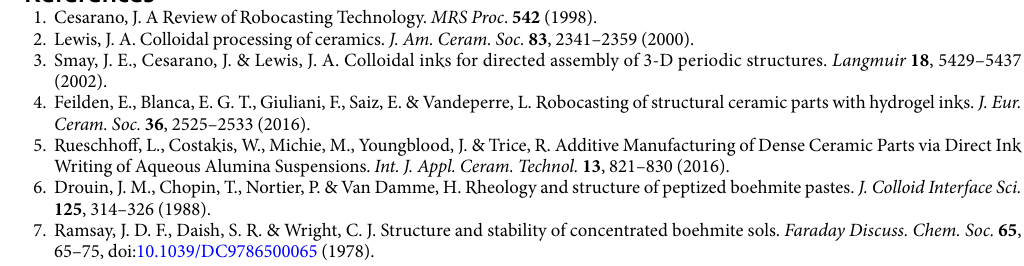
layer. These surface defects are inherent to most of additive manufacturing techniques as layer-by-layer building forcibly leaves traces on the sample boundaries. Figure 10 shows that on the contrary, inside the sample, all signs of layer stacking disappears. Lines have perfectly merged to each other to produce a dense object, and even after sintering, printing does not leave traces inside the sample and layers can not be distinguished. Figure 10b shows a higher magnification (x10k) of the same sample. The microstructure has an average grain size of 1 μ m , with a high population of submicronic grains. Residual porosity is predominantly located at triple-point.